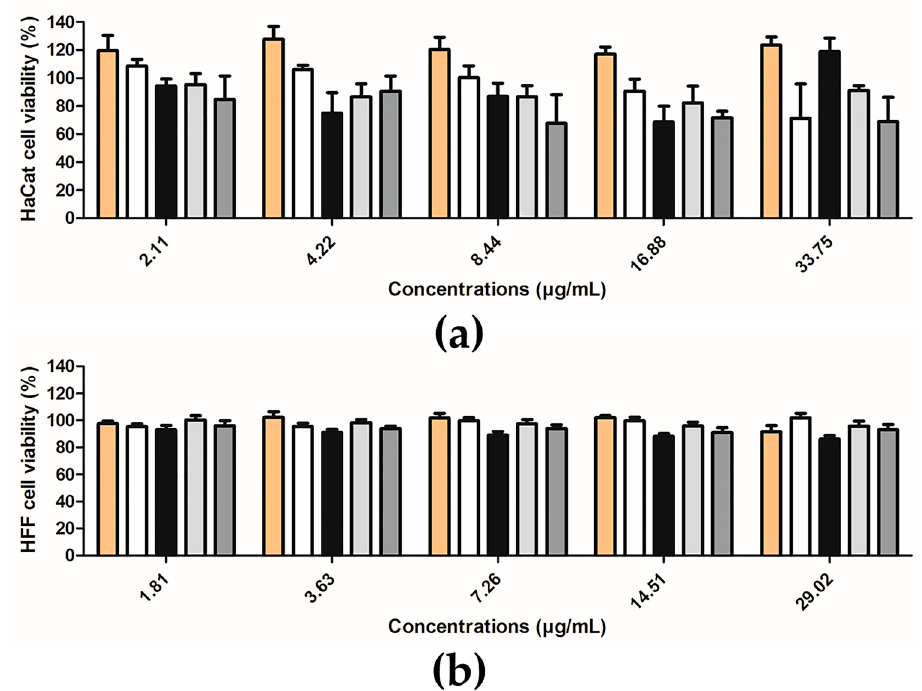
Figure 13. Cell viability (%) of ( a ) HaCaT and ( b ) HFF cells after 48 h incubation (%, mean ± S.D.; n > 4): free extract (orange columns), empty PLGA NPs (white columns), extract-loaded PLGA NPs (black columns), empty PCL NPs (light grey columns) and extract-loaded PCL NPs (dark grey columns).